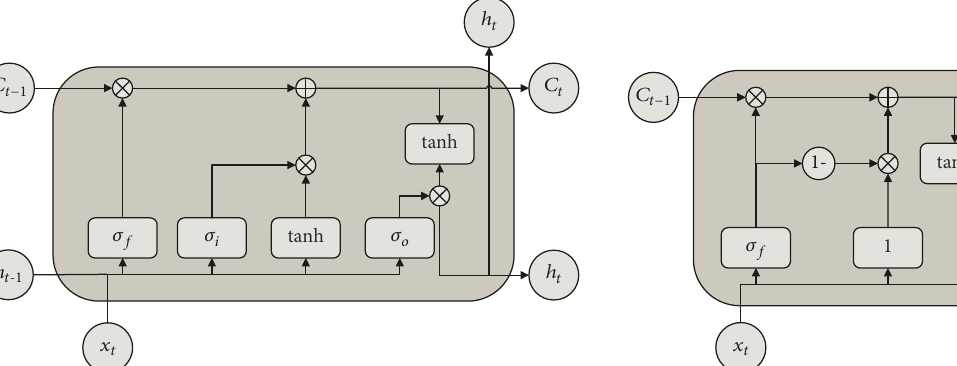
Figure 6: The structure diagram of the LSTM cell: 휎 𝑓 , 휎 𝑖 , and 휎 𝑜 are the logistic sigmoid activation function of forget gates, input gates, and output gates. 푥 𝑡 , ℎ 𝑡−1 ,푐 𝑡−1 are the inputs of the LSTM cell; ℎ 𝑡 and 푐 𝑡 represent the outputs of the LSTM cell.